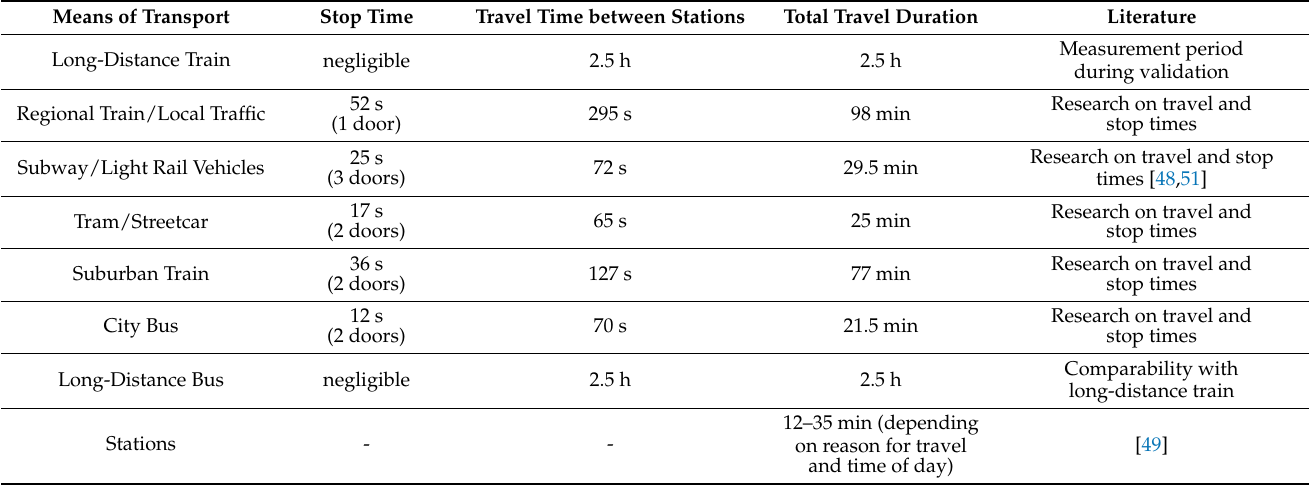
Table 4. Typical travel profiles and durations of stay in the different means of transport and stations.